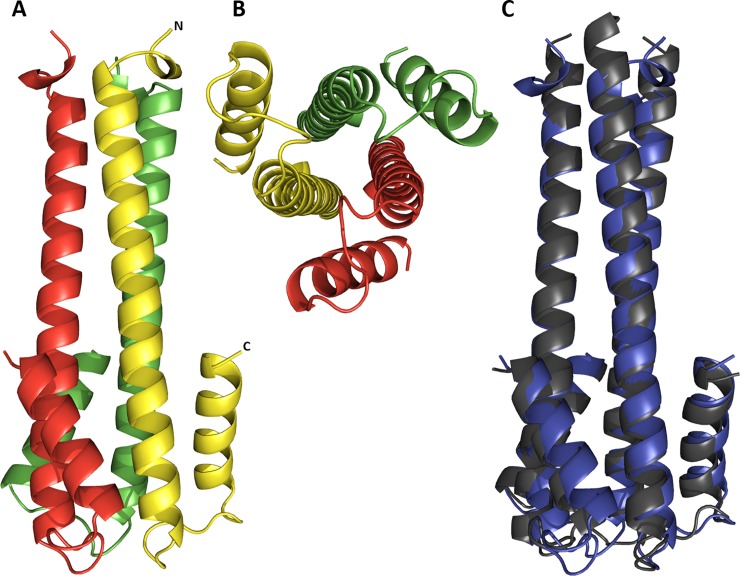
The structure of HA tri-stalk at pH 5.5.Side (A) and top (B) view on tri-stalk protein. Individual monomers are colored in red, green and yellow. (C) Structural alignment of HA tri-stalk protein (blue) with the corresponding stem fragment of native post-fusion HA (grey) (PDB code 1HTM, residues 63 to 127). Only matching sequence length is shown for clarity.